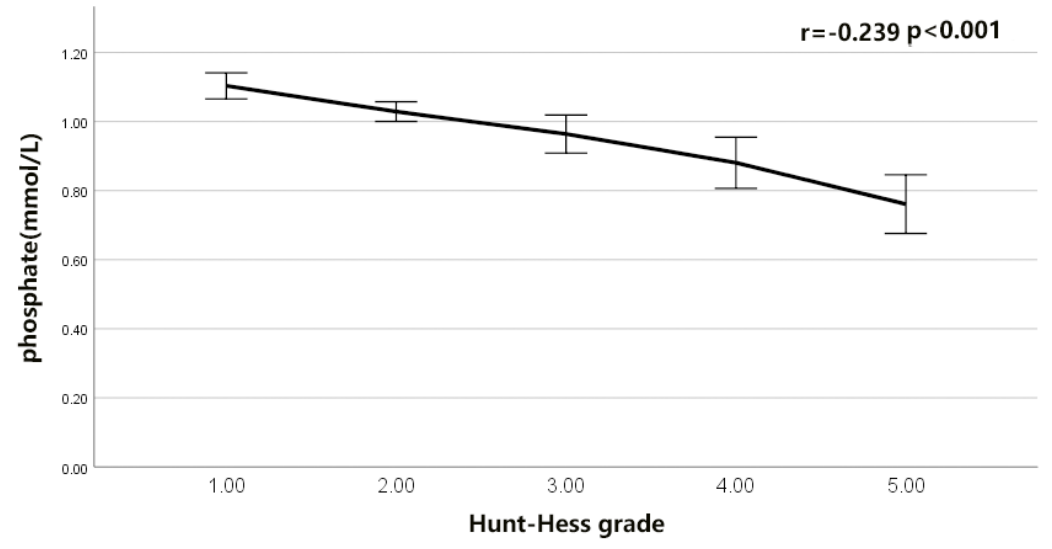
Figure 3. Correlation of LDH with Hunt−Hess grade after intracranial aneurysm rupture.